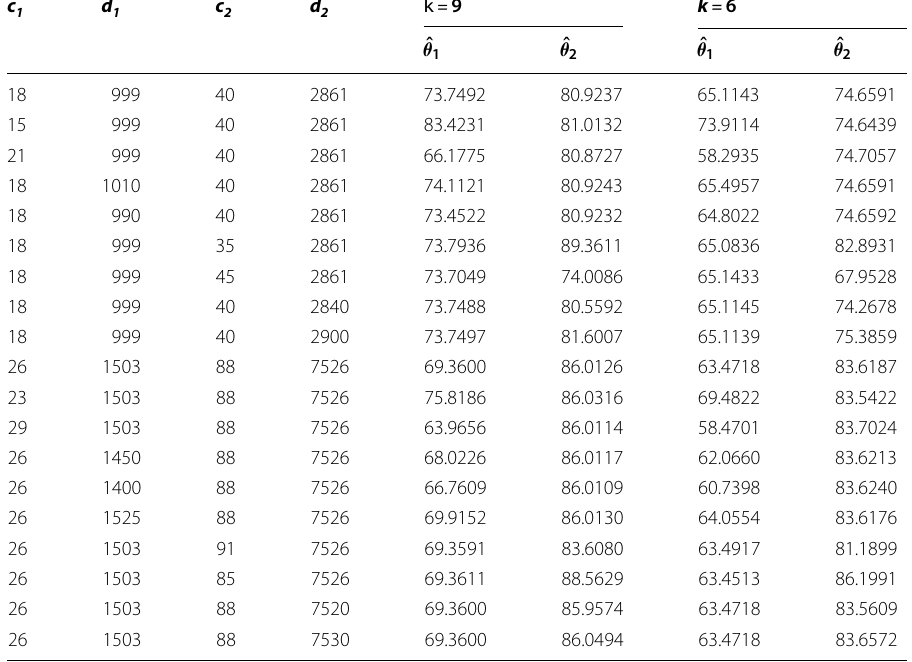
Table 7 Bayes estimates of mean life